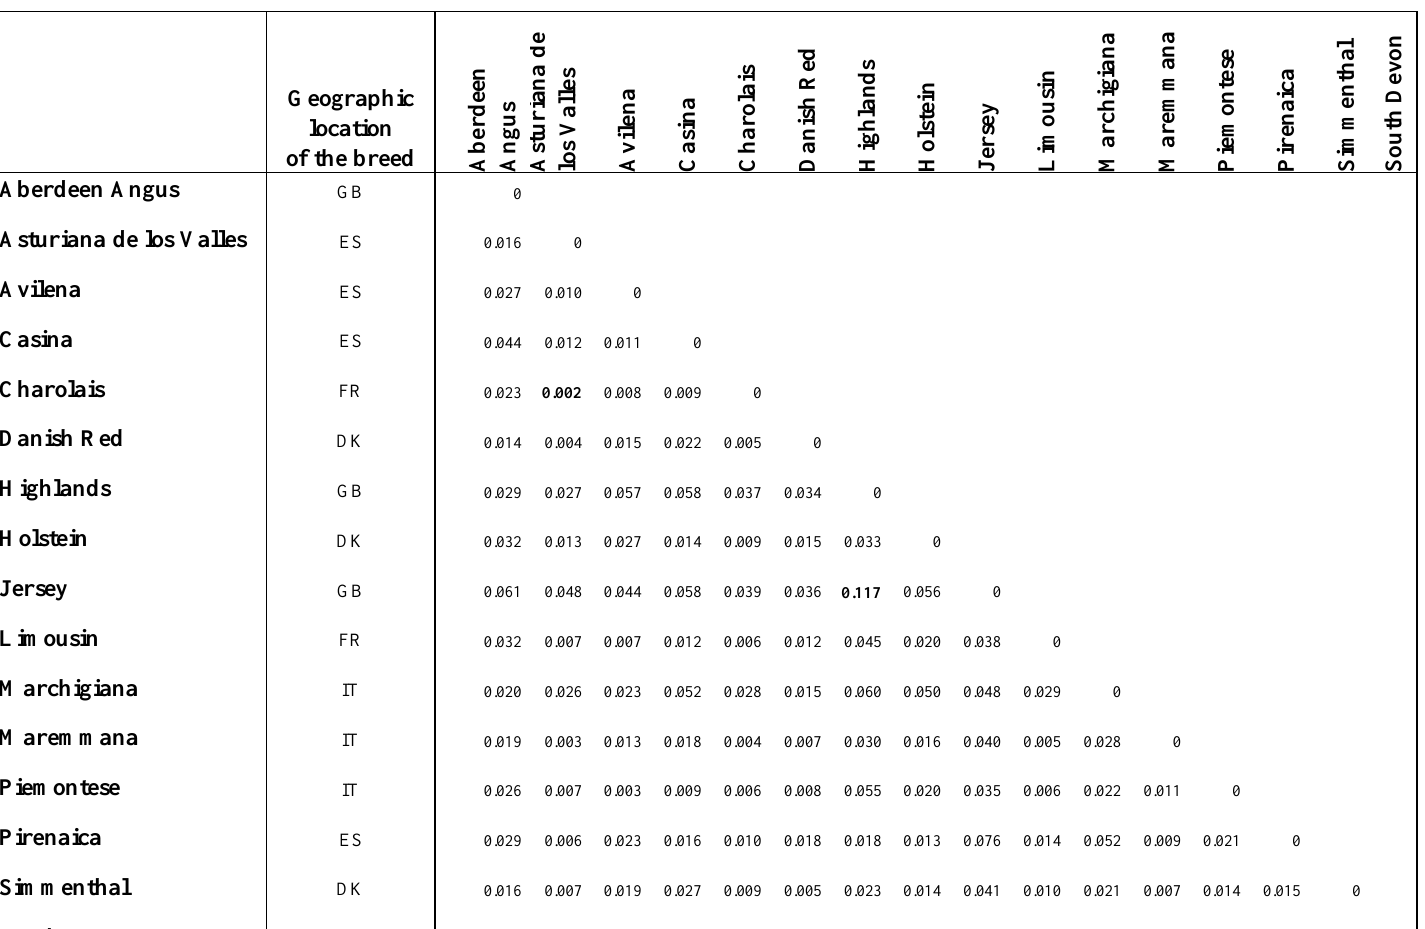
Table 6 . Nei genetic distances. GB: Great Britain; ES: Spain; FR: France; DK: Denmark; IT: